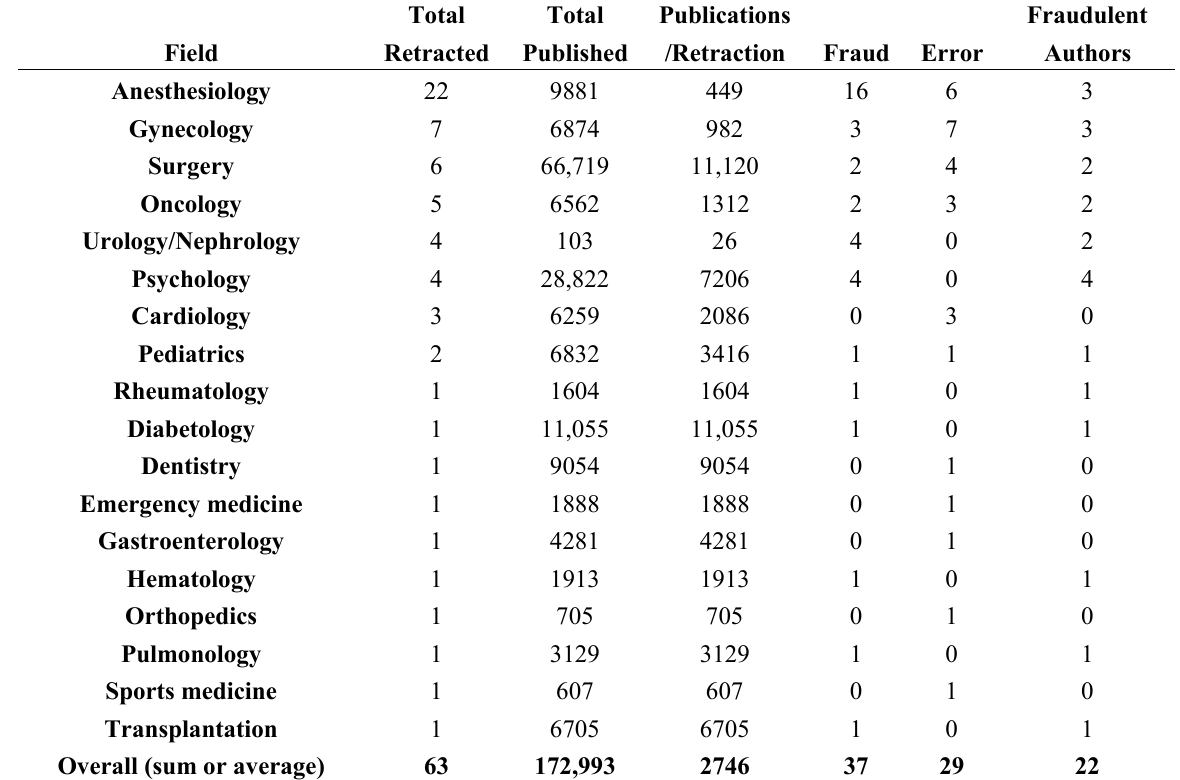
Table 2. Retracted randomized clinical trials (RCTs) characterized by the field of medicine. “Publications/Retraction” was calculated by dividing “total published” by “total retracted” in each row. Anesthesiology had proportionally more retractions than every other